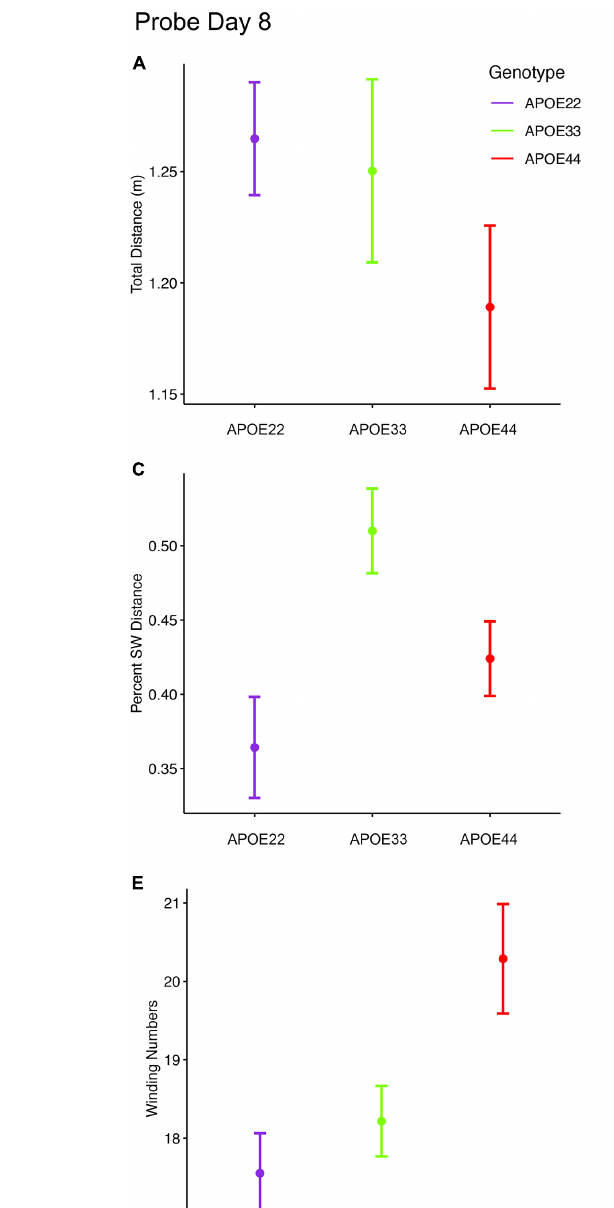
APOE2 ( t = − 2.4, p = 0.02), APOE3 ( t = − 2.9, p = 0.008), APOE4 ( t = − 2.3, p = 0.03). Differences between males and females were significant within APOE2 mice ( t = − 2.4, p = 0.02), APOE3 mice ( t = − 2.9, p = 0.008), and APOE4 mice ( t = − 2.3, p = 0.03).